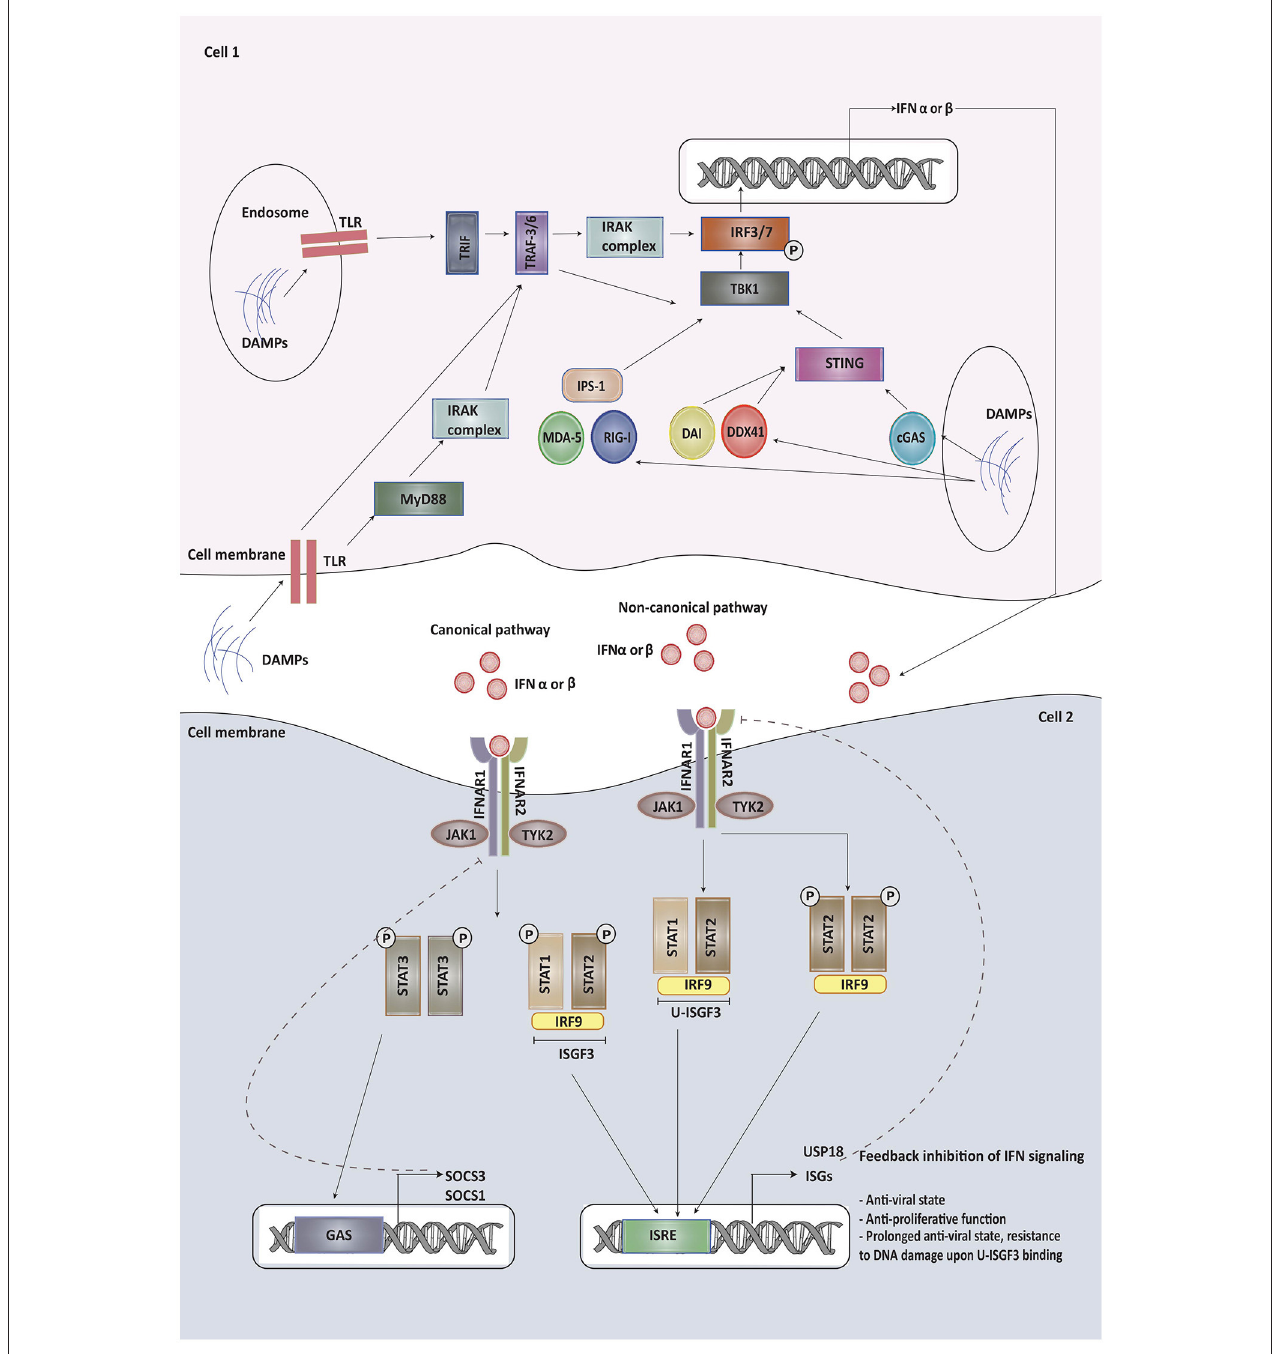
FIGURE 1 | Type I IFNs are secreted by infected cells upon recognition of damage associated molecular patterns (DAMPs) and pathogen associated molecular patterns (PAMPs) by pattern recognition receptors (PRRs), which include transmembrane Toll-like receptors (TLRs), cyclic GMP-AMP synthase (cGAS), RIG-I like receptors, MDA-5, DDX41, and DAI. Once these sensors have been activated, they interact with adaptor proteins, such as TIR-domain-containing adaptor inducing IFN (TRIF), MyD88 adapter-like (Mal), mitochondrial anti-viral signaling protein (MAVS) or STING. These adapter proteins recruit kinases indirectly or directly, which then phosphorylate IFN regulatory factor 3/7 triggering its translocation into the nucleus, where it binds to the regulatory domains of the IFN- β / α gene promoter. Upon production, type I IFNs signal via a transmembrane receptor composed of IFNAR1 and IFNAR2 subunits. Canonically, upon binding to IFN, IFNAR phosphorylates and activates the receptor-associated Janus kinase 1 (JAK1) and tyrosine kinases 2 (Tyk2), which subsequently lead to the phosphorylation of signal transducer and activator of transduction 1 and 2 (STAT1 and STAT2) present in the cytosol. Upon activation, these proteins dimerize, get translocated to the nucleus and bind to IRF9 to form a STAT1-STAT2-IRF9 complex (ISGF3). This complex then binds to IFN stimulated response elements (ISRE) in the promoter region of IFN-stimulated genes